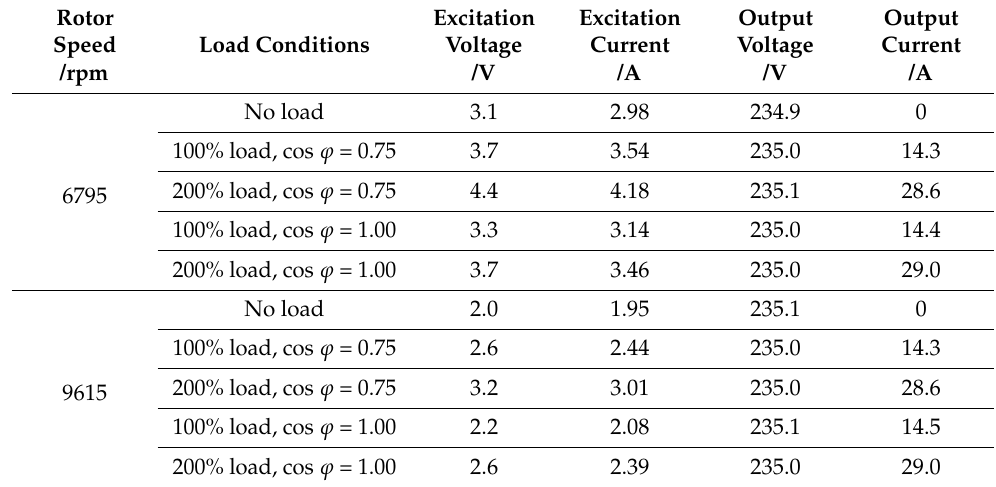
Table 10. Generator steady-state test data.